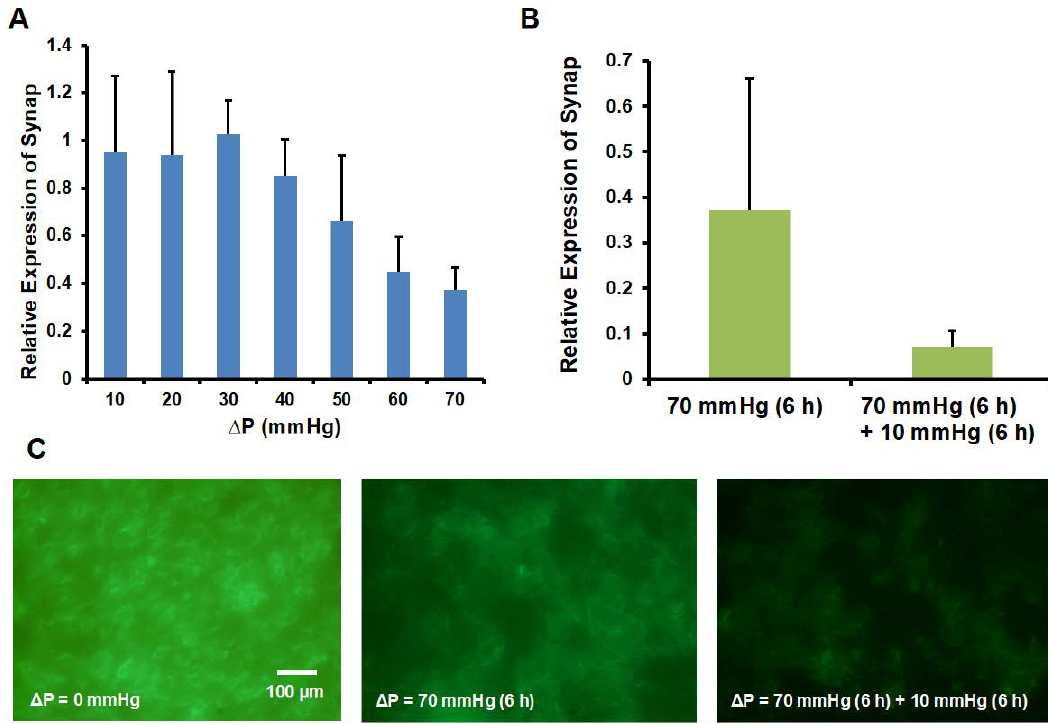
Figure 7. q-PCR analysis of the relative expression of ( A ) synaptopodin by applying Δ P for 6 h, ( B ) synaptopodin by applying Δ P = 70 mmHg for 6 h or Δ P = 70 mmHg for 6 h followed by Δ P = 10 mmHg for 6 h. Data are shown as mean ± SD ( n ≥ 2). ( C ) Immunofluorescence staining of actin for culture applied with Δ P = 0 mmHg (left), Δ P = 70 mmHg for 6 h (middle) and Δ P = 70 mmHg for 6 h followed by Δ P = 10 mmHg for 6 h (right).